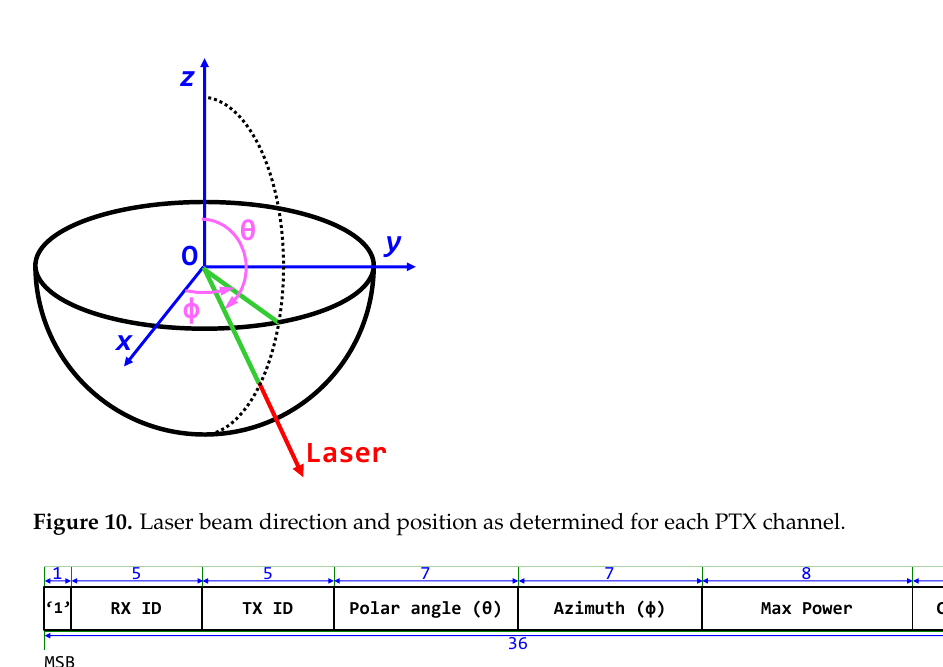
Figure 11. Unique PCI packet format transmitted from a